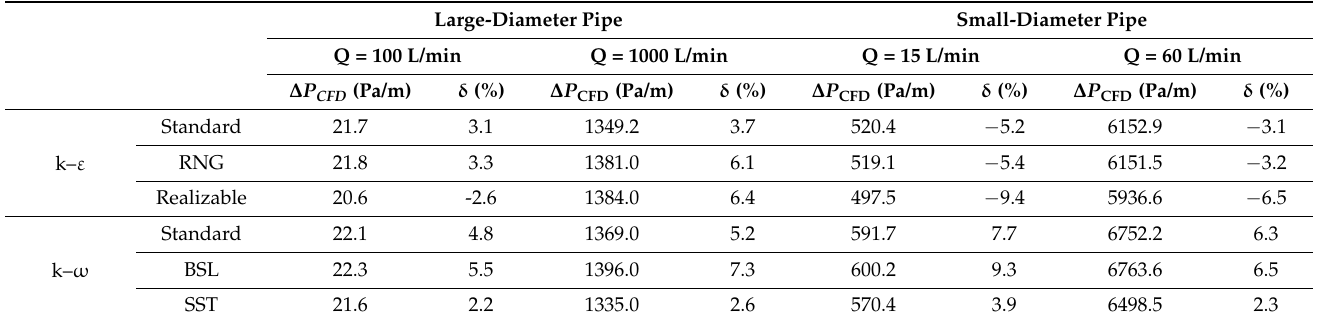
Table 4. Comparison between experimental results and CFD-predicted pressure